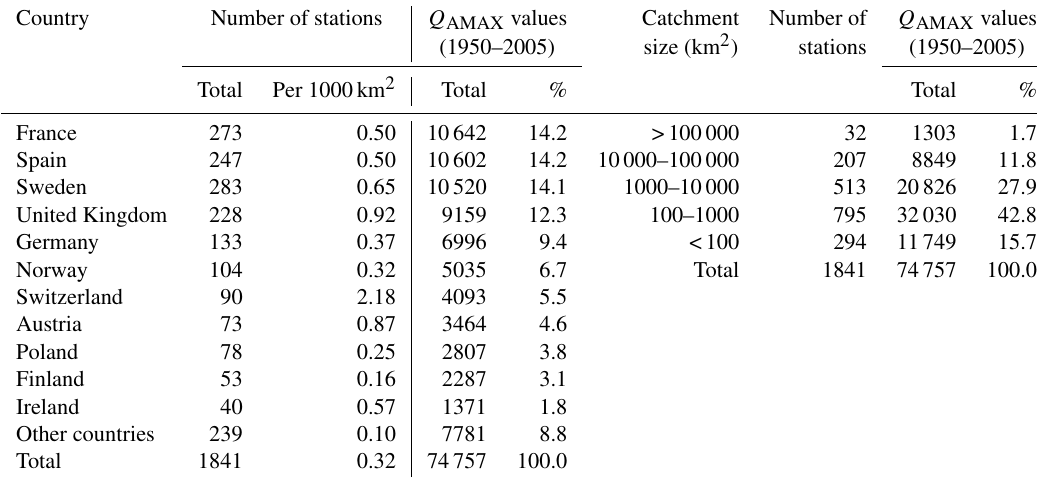
Table 1. Summary statistics of stations used in the work. Country Number of stations Q AMAX values